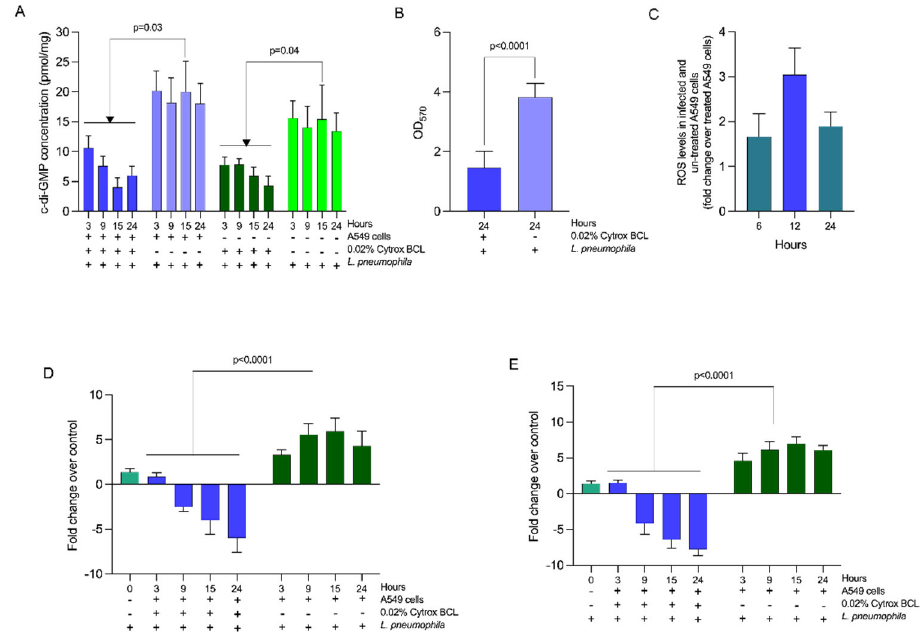
Figure 3. Intracellular concentration of c-di-GMP levels, biofilm formation and virulence gene expression. Panel ( A )—c-di-GMP levels; Panel ( B )—biofilm biomass; Panel ( C )—ROS levels in in ‐ fected and un ‐ treated A549 cells; Panels ( D , E )—transcriptional analysis of tat B and tat C. Data are presented as the mean ± SD. Student’s t ‐ test was used to analyse the statistical significance as indi ‐